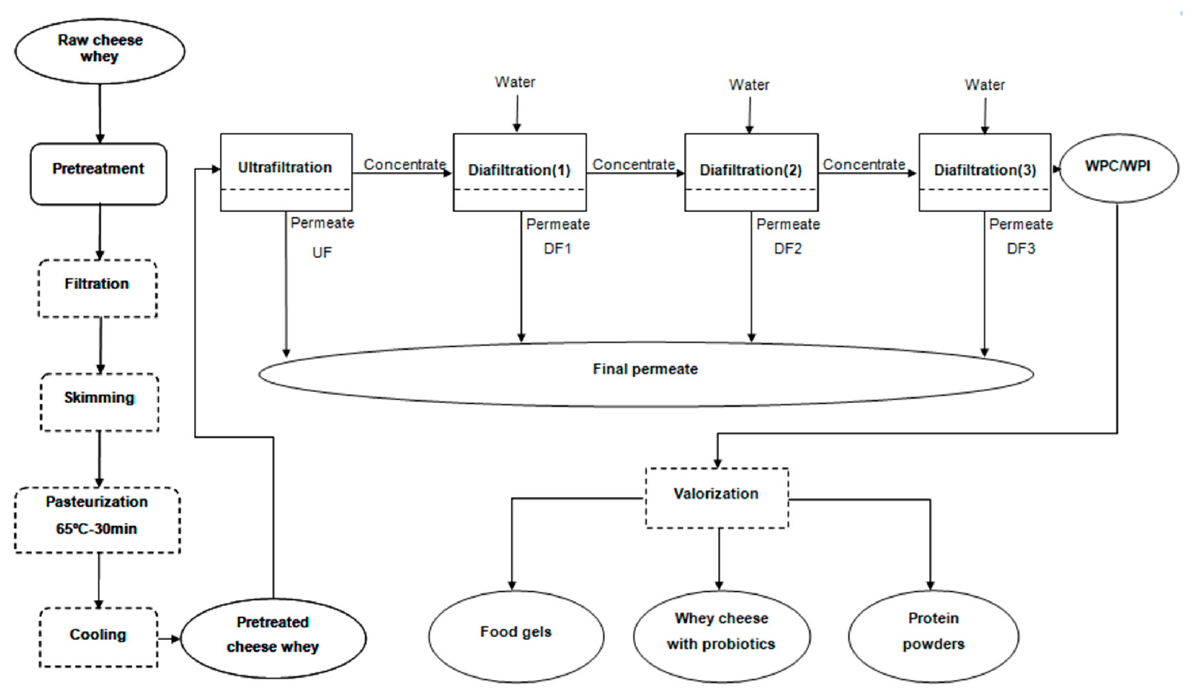
Figure 1. Experimental plane.